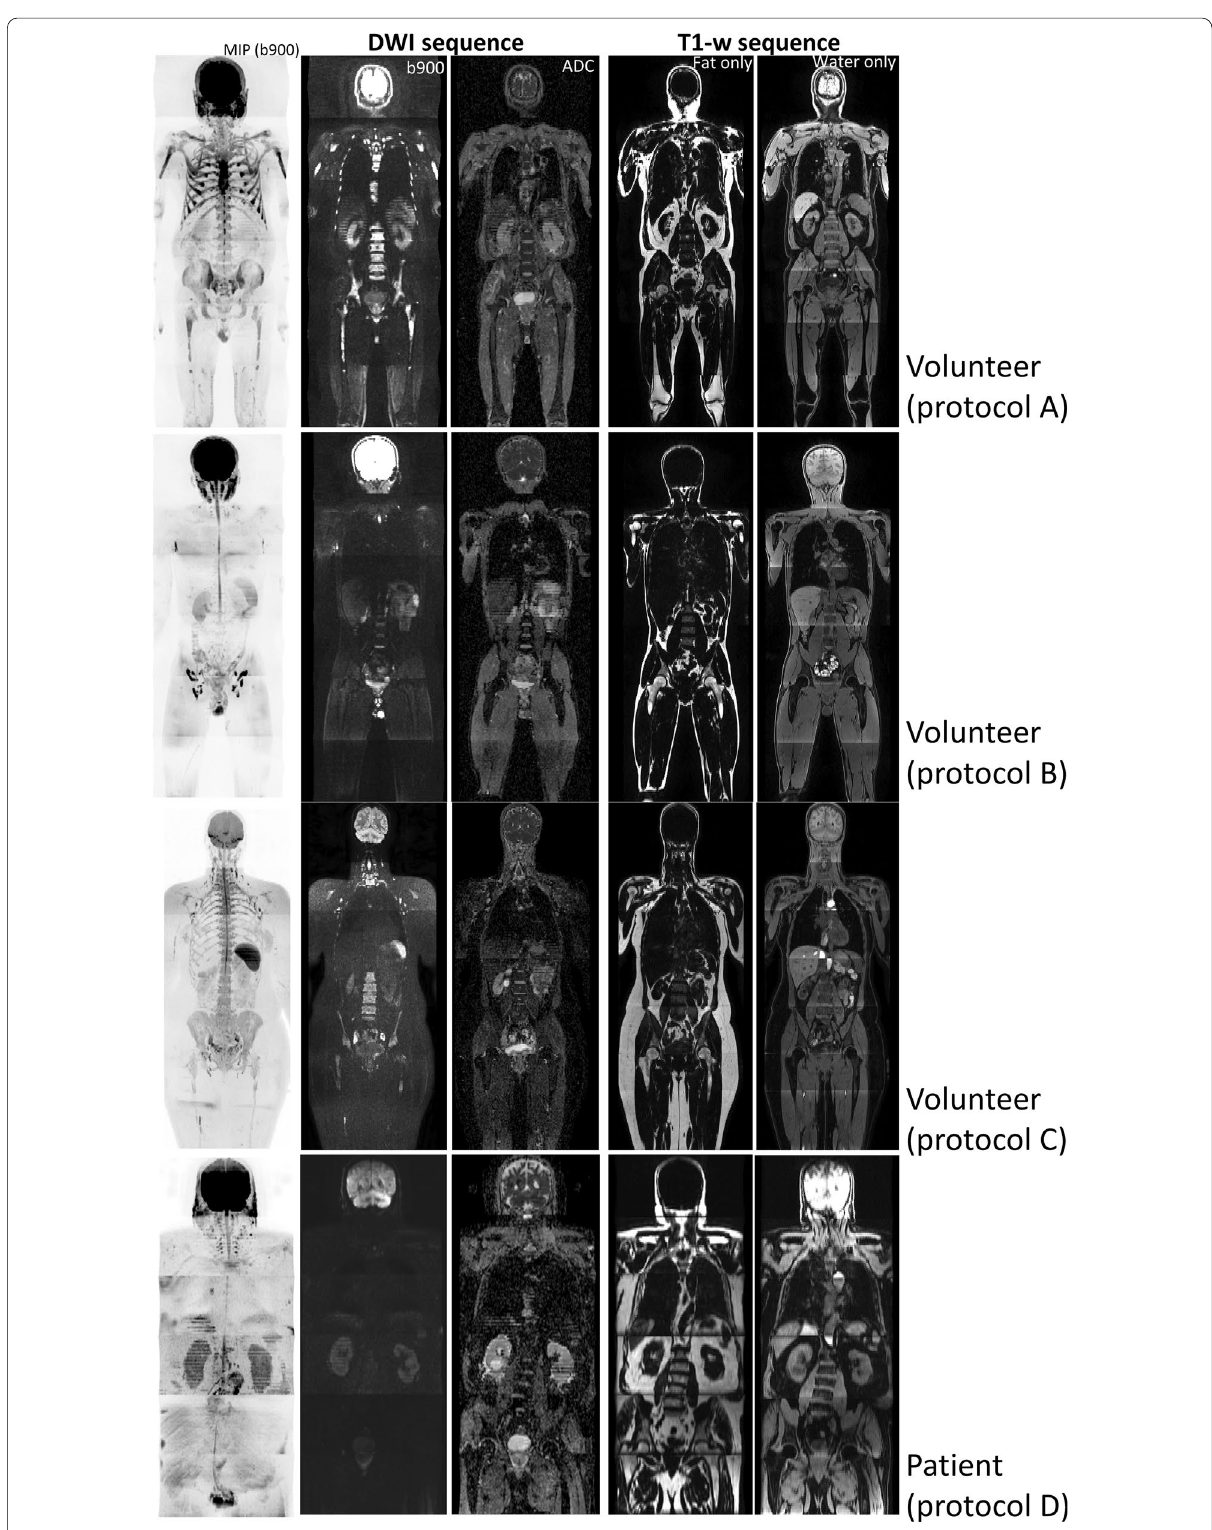
Fig. 3 Volunteer/patient images acquired using the four main MR protocols. Coronal reconstructions showing composed MIP, b900 and ADC images (for DWI sequence) and composed fat‑ and water‑only images (for T 1 ‑w Dixon sequence) for protocol A (Siemens 1.5 T), B (Siemens 3 T), C (Philips 1.5 T) and D (GE 3